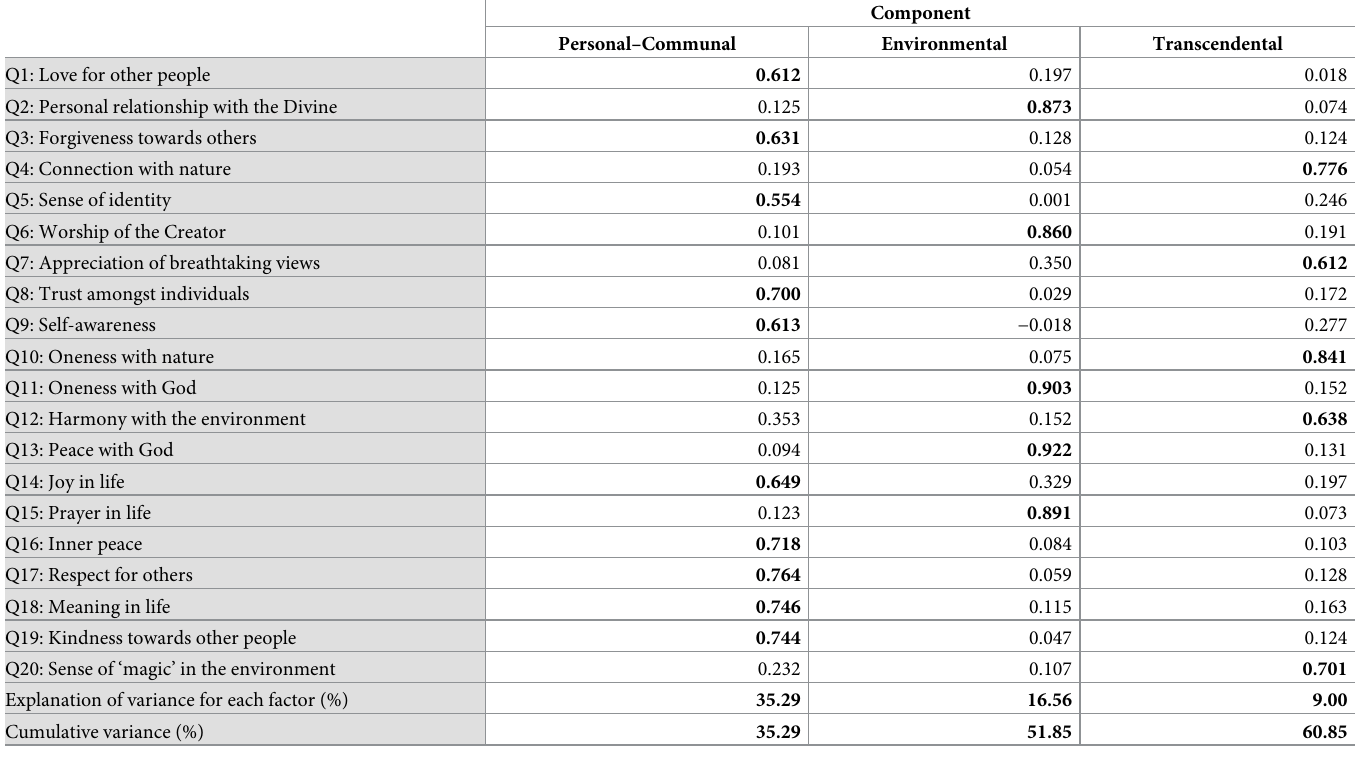
Table 1. Results of Exploratory Factor Analysis of the SHALOM items (N = 500).